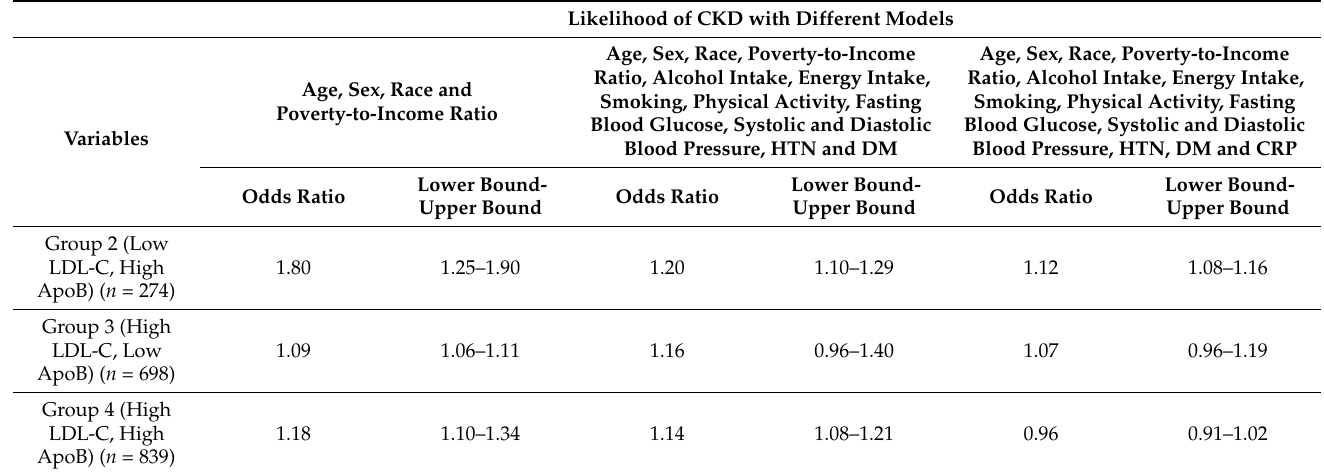
Table 3. Adjusted logistic regression to examine the association between LDL-C and ApoB concor- dant/discordant categories and chronic kidney disease